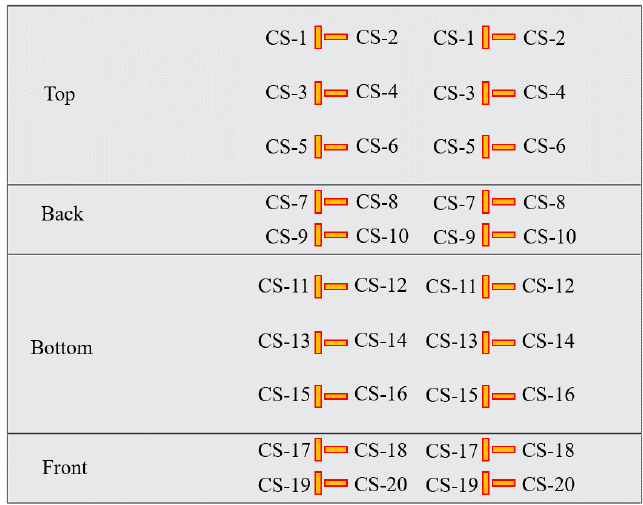
Figure 6. The arrangement of strain measuring points.